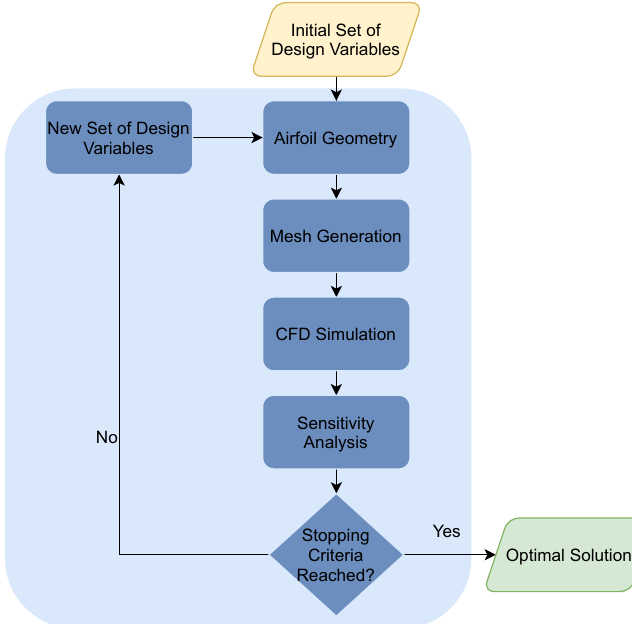
Figure 1. General algorithm for the ASO